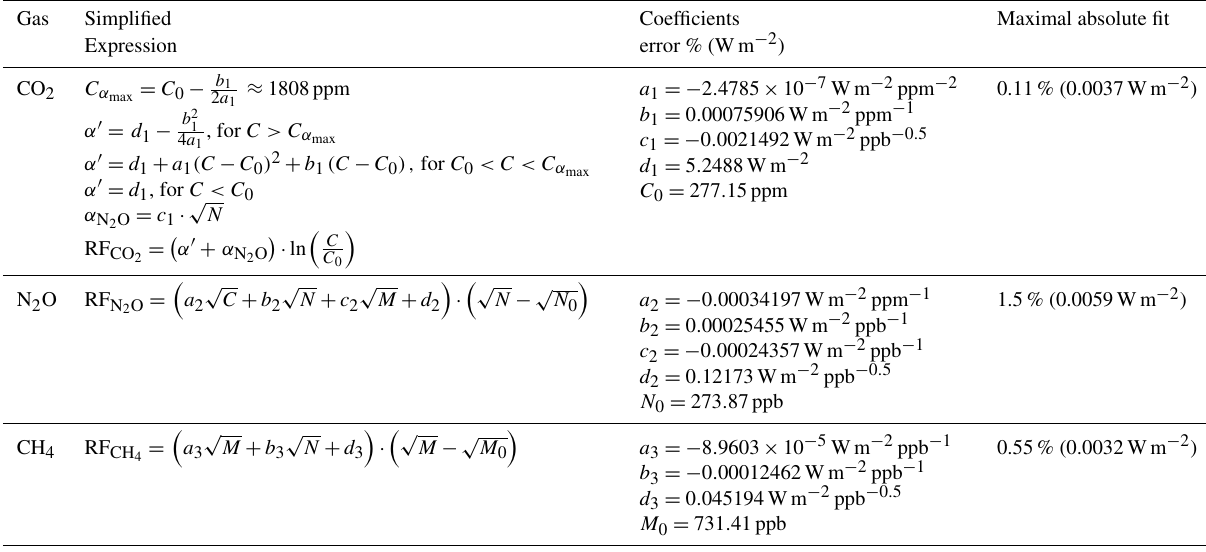
Table 3. Simplified expressions for radiative forcing relative to pre-industrial (1750) levels by changes in surface air mole fractions of CO 2 , CH 4 , N 2 O – reflecting the Oslo Line-by-Line model results. This table can be compared to Table 1 in Etminan et al. (2016), but note that their formulas can be directly applied to any sets of ( C , Co), ( M , Mo), and ( N , No) within the range of fitting, unlike the case here where Co, Mo, and No are pre-specified at pre-industrial